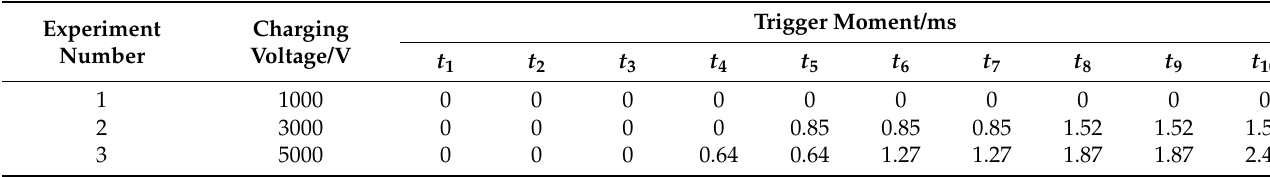
Table 2. The charging voltage configuration and sequence.